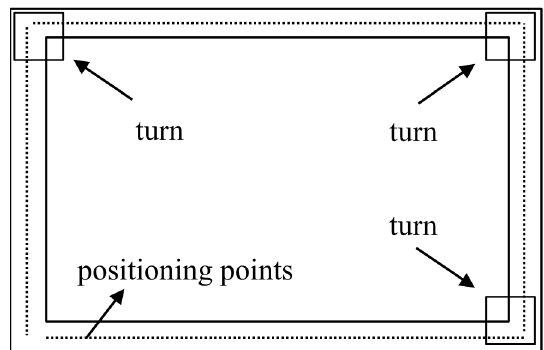
Figure 5. Accumulated gyroscope values during each step.